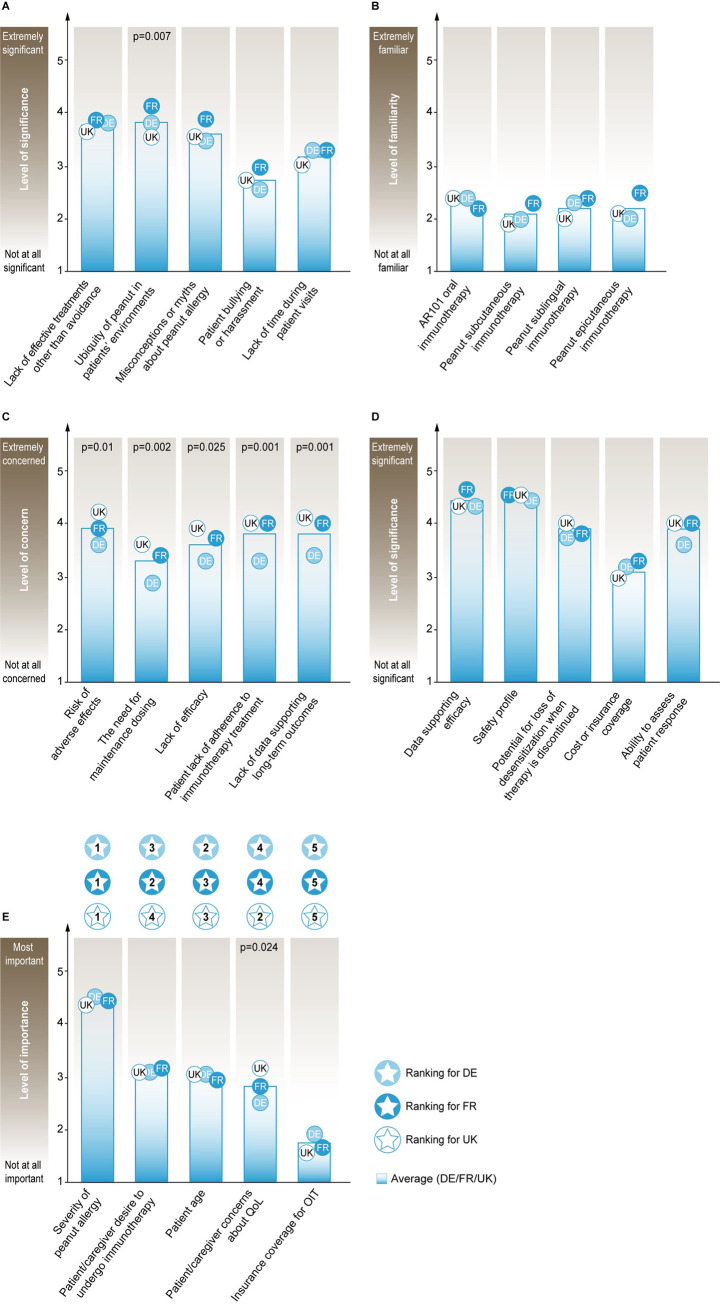
Factors influencing decision-making regarding PA treatment.Panels A-E: Mean scores of allergists’ responses are shown. A. Significant barriers to the optimal management of patients with PA. B. Familiarity with clinical trials regarding emerging therapies for PA. C. Concerns with aspects related to investigational OIT for PA. D. Significance of factors in selecting between treatments, if multiple immunotherapies for PA become available. E. Factors important in the decision to recommend OIT for PA treatment ranked with the highest score at 1st Rank and lowest at 5th Rank; Blue gradient bar shows average results for responses from France (FR), Germany (DE) and the United Kingdom (UK) (n = 109; FR (36), DE (38), UK (35)), and circles represent individual countries with the respective two-letter acronym. Only statistically significant p-values from ANOVA tests comparing differences among the three individual countries (p ≤ 0.05) are shown in figures. PA, peanut allergy; OIT, oral immunotherapy.